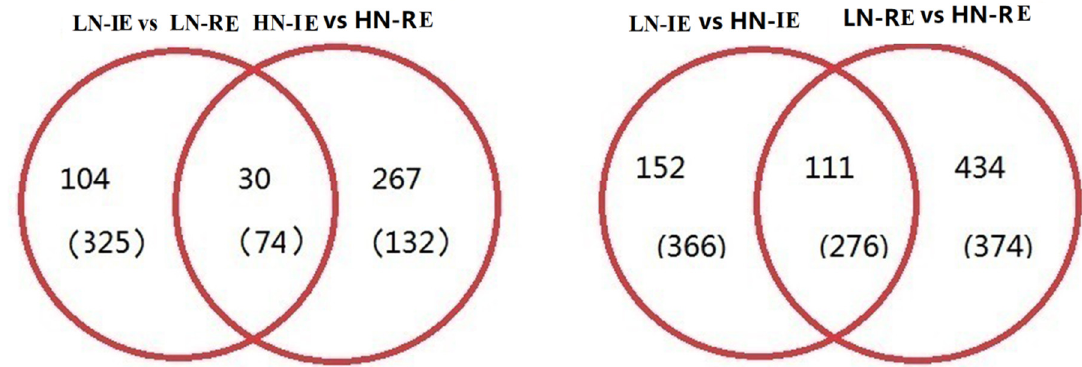
Figure 1. Ven diagram of differentially expressed genes in different parts of wheat grain endosperm under high and low nitrogen treatments. HN-IE and HN-RE are samples from innermost endosperm region and the remaining endosperm region under high nitrogen treatment, respectively. LN-IE and LN-RE are samples from innermost endosperm region and the remaining endosperm region under low nitrogen treatment, respectively. The number outside (inside) brackets stand for up-regulation (down-regulation) differentially expressed genes.